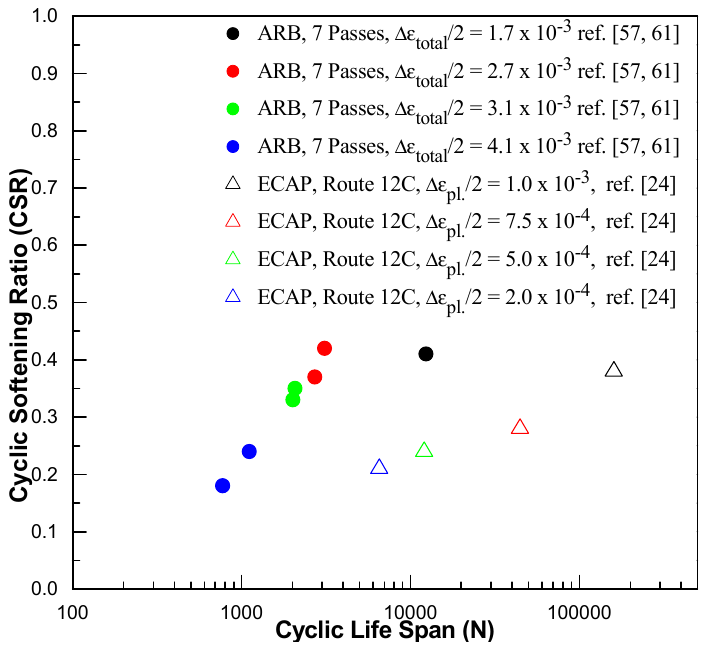
Figure 3. A plot illustrating the correlation between the extent of the cyclic softening ratio according to [24] and the cyclic lifespan of ARBed and ECAPed OFHC